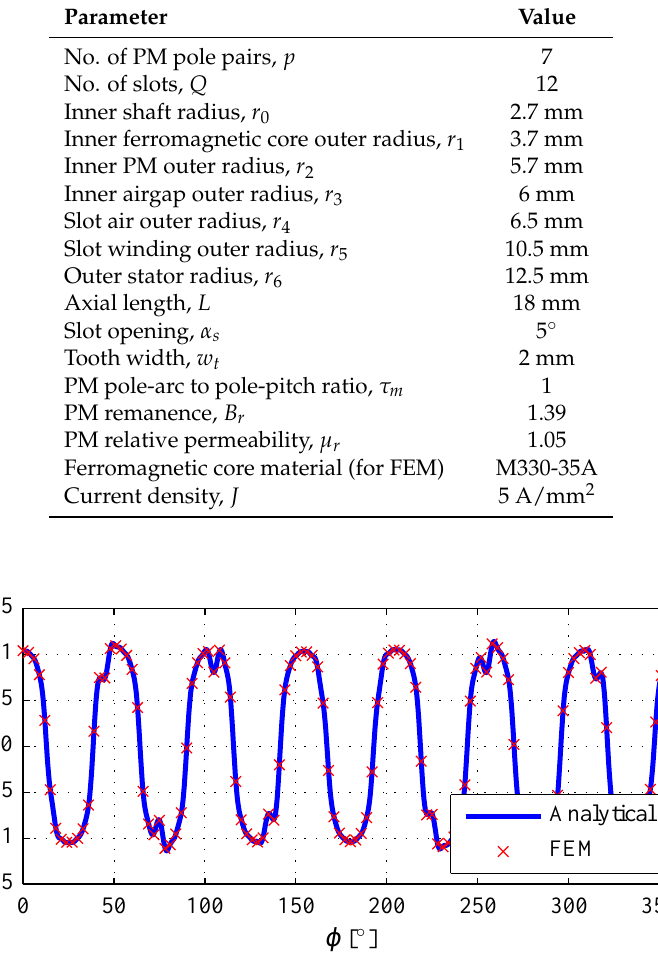
Figure 6. Airgap radial magnetic flux density (region II) of the motor. Table 3. Simulation duration of the analytical and FEM (Finite Element Method) models, as